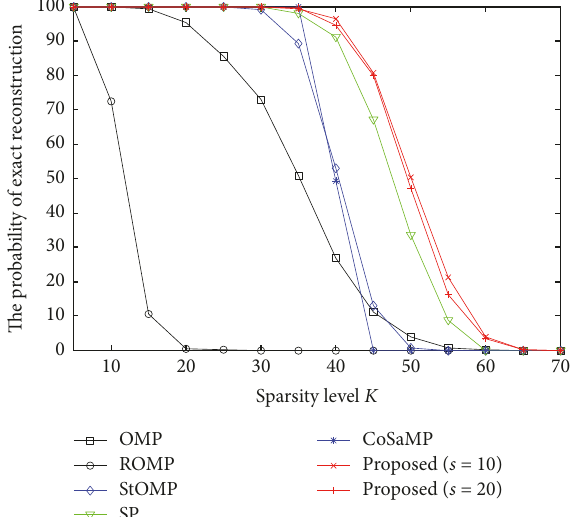
Figure 1: Reconstruction performance for 𝐾 -sparse Gaussian signal vector as a function of sparsity 𝐾